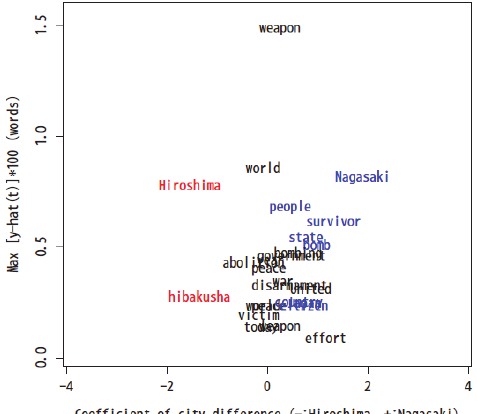
Fig. 7. A grouped time trend of city effects on keyword's frequency when K=3